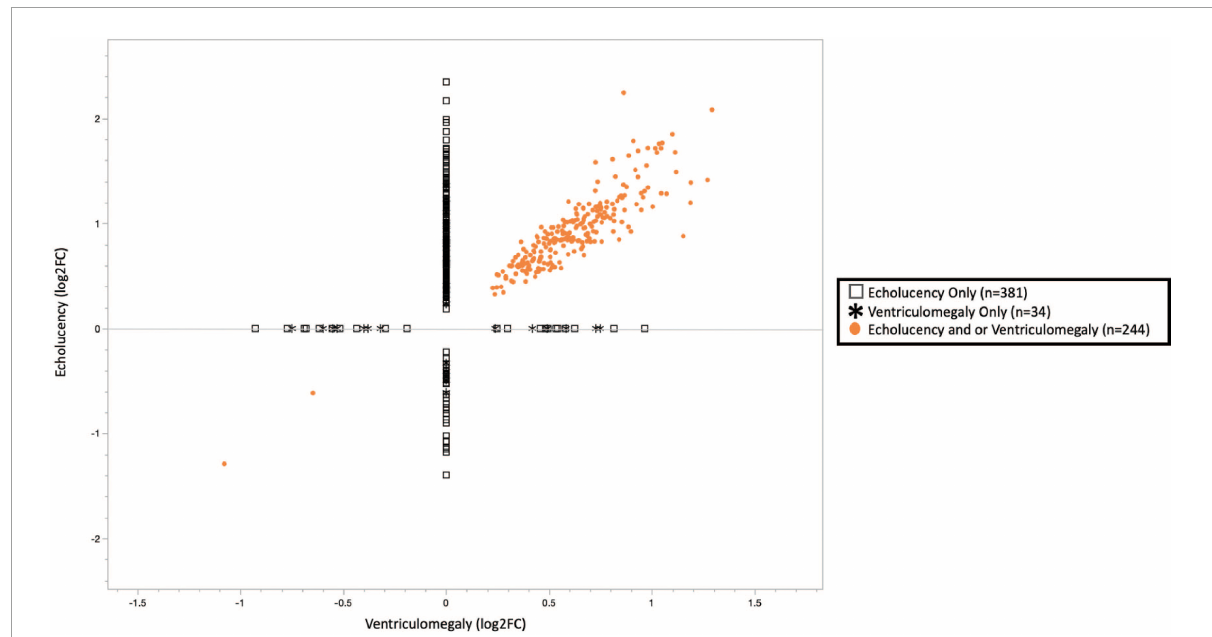
FIGURE2 Plot of cerebral white matter damage-associated genes ( n = 659). Similar patterns of gene expression were identified for the common gene set ( n = 244), 242 or 99.2% genes had increased expression while 2 or 0.8% had decreased expression. While 63% of the echolucency and ventriculomegaly-associated genes displayed distinct expression levels. Log2-fold changes in mRNA expression associated with ventriculomegaly vs. echolucency. Data points colored in orange indicate genes significantly upregulated or downregulated (FDR p -value < 0.1) associated with both ventriculomegaly and or echolucency, data points denoted by an open square indicate genes significantly (FDR p -value < 0.1) associated with echolucency, and data points denoted by a star indicate genes significantly (FDR p -value < 0.1) associated with